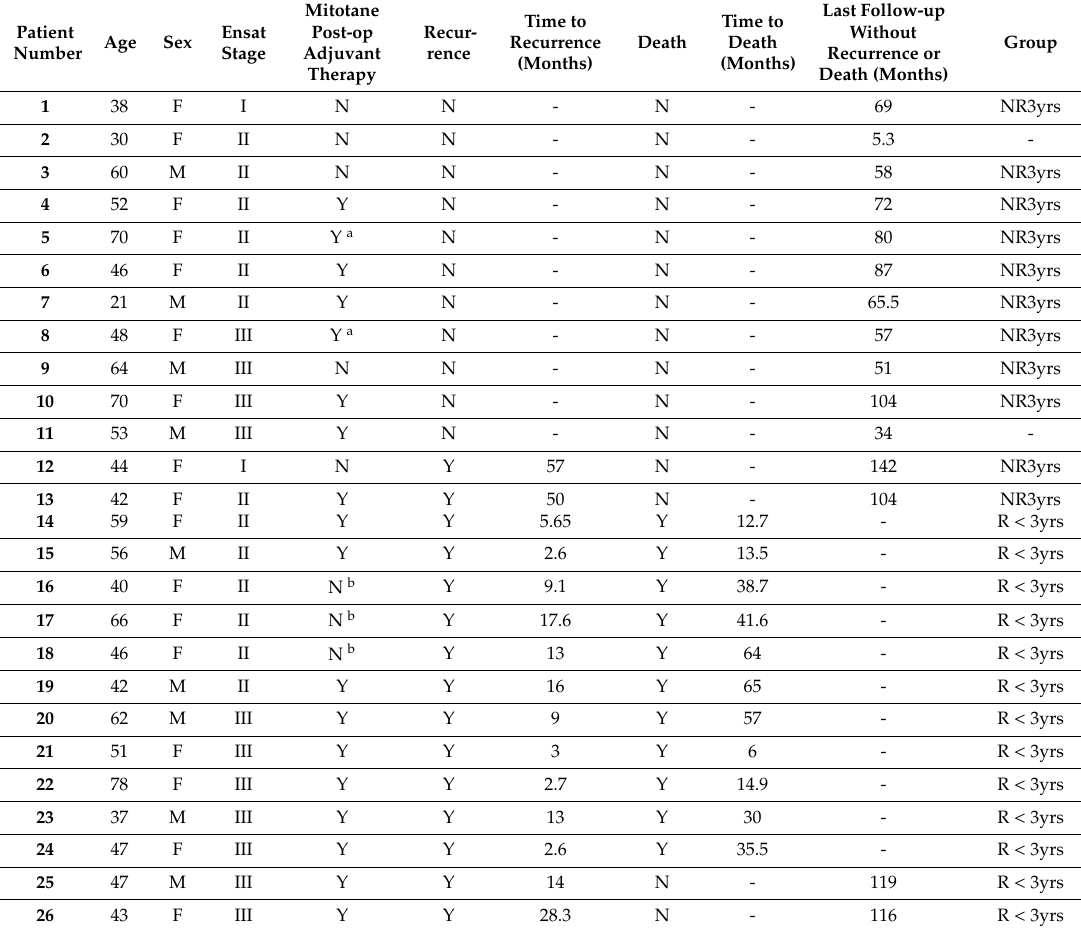
Table 1. Clinical characteristics of the 26 patients with adrenocortical cancer (ACC) with serum sampled within 3 months after surgery.